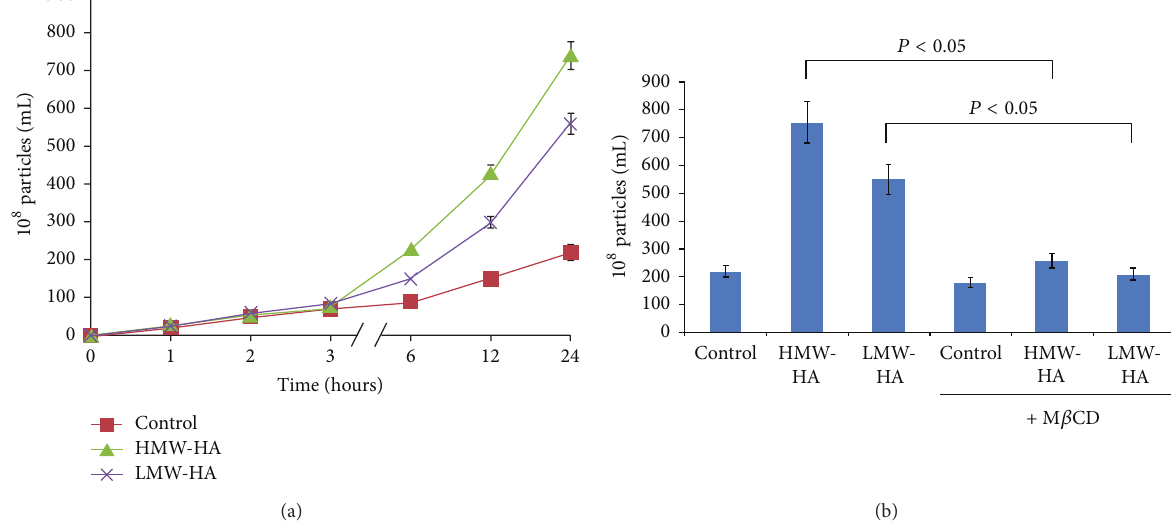
Figure 1: Determination of extracellular vesicle (EV) release kinetics and caveolin-enriched microdomain (CEM) dependence in human endothelial cells (EC). Panel (a): graphical representations of the kinetics of HA-induced EV release from human pulmonary microvascular endothelial cells (HPMVEC). Human EC monolayers were placed in serum-free media and the resulting media containing EV were collected at0,1,2,3,6,12,and24hours.TheconcentrationsofEVweredeterminedutilizingnanosightnanoparticletrackinganalysis(NTA).HPMVEC exhibit basal secretion of EV (control). However, addition of 100nM HMW-HA or 100 nM LMW-HA dramatically increased the production of EV starting at ∼ 6 hours posttreatment. 𝑁 = 3 per group and error bars = standard deviation. Panel (b): graphical representation of the role of CEM in HA-mediated EV production from human EC. HPMVEC monolayers were either untreated or treated with 5 mM methyl- 𝛽 -cyclodextrin (M 𝛽 CD, a CEM disrupting agent) with or without addition of 100 nM LMW-HA or 100 nM HMW-HA (24 hours). EVs were analyzed as described in Panel (a). Inhibiting CEM formation significantly inhibited both LMW-HA and HMW-HA-mediated EV secretion with 𝑛 = 3 per group and error bars = standard